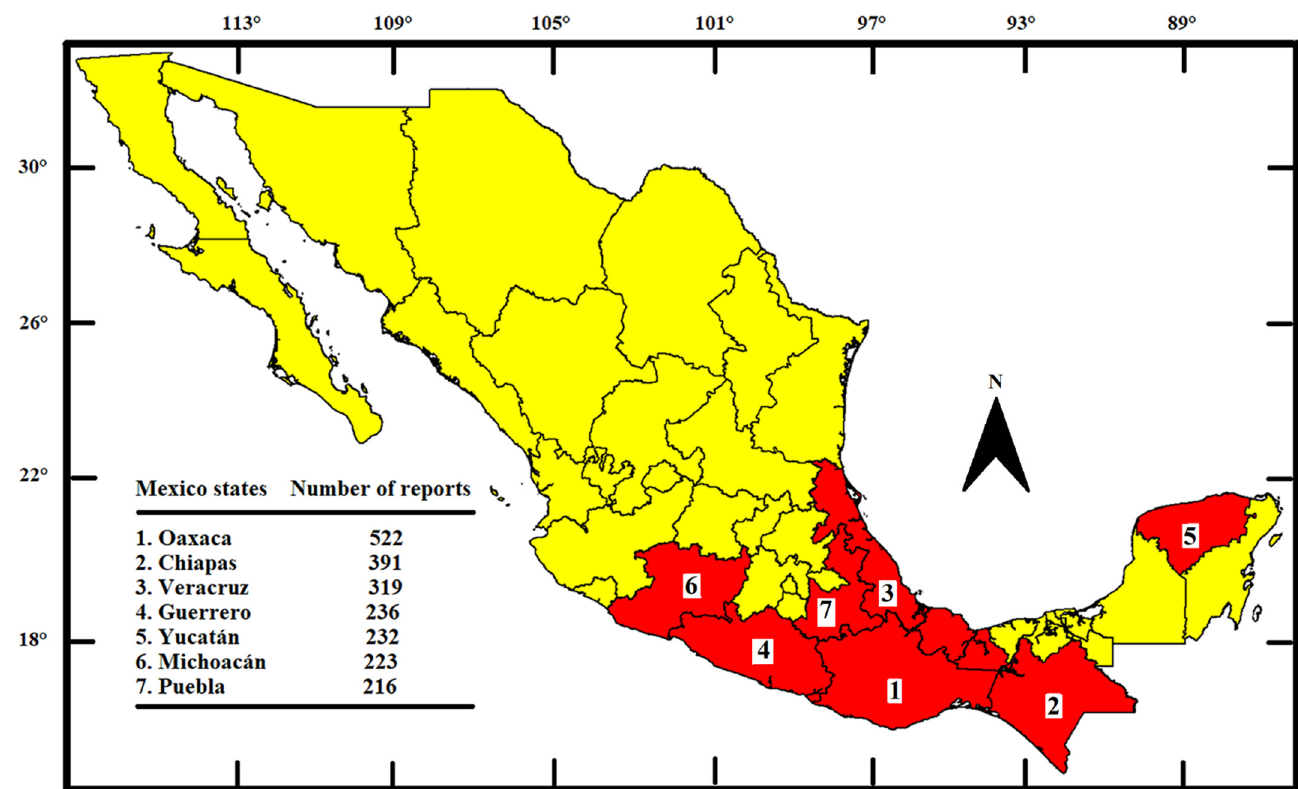
Figure 2. Map representing the Mexican states with more useful native legumes reports at